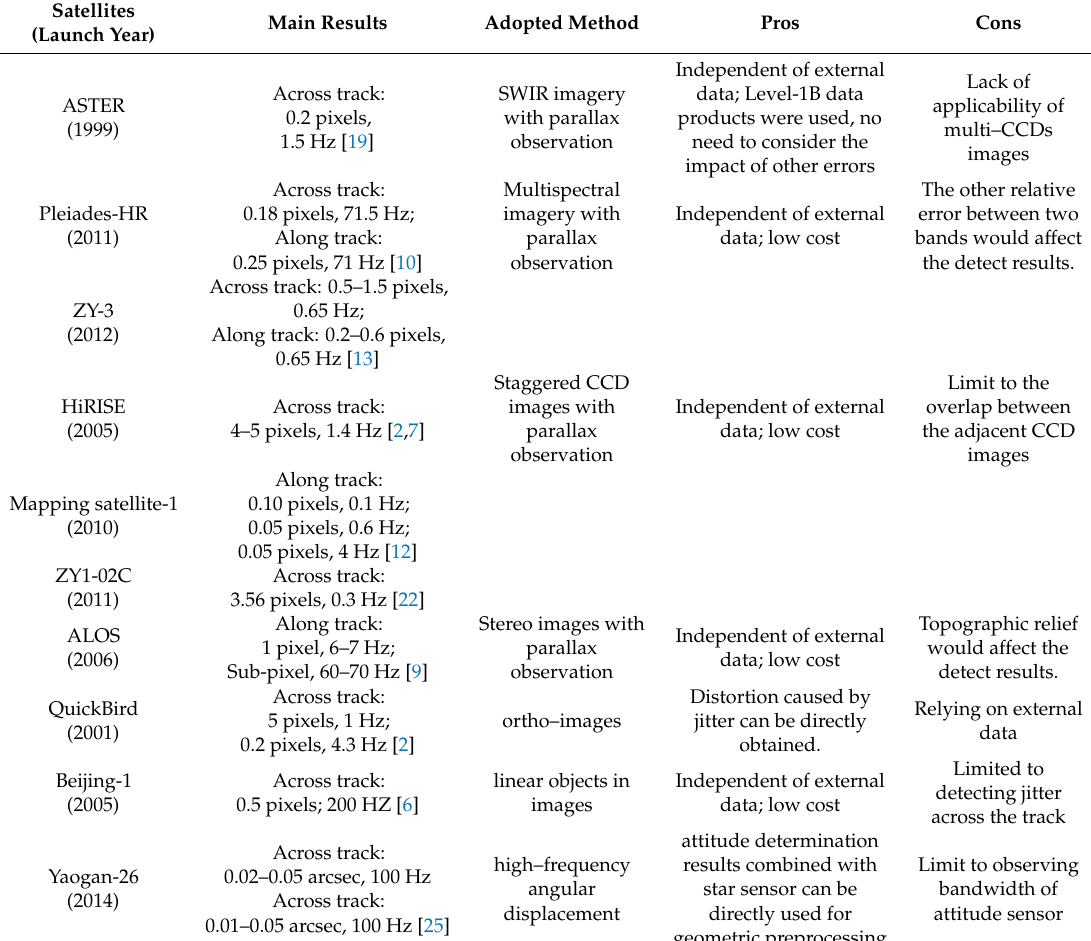
Table 1. The state-of-the-art jitter detection results and adopted